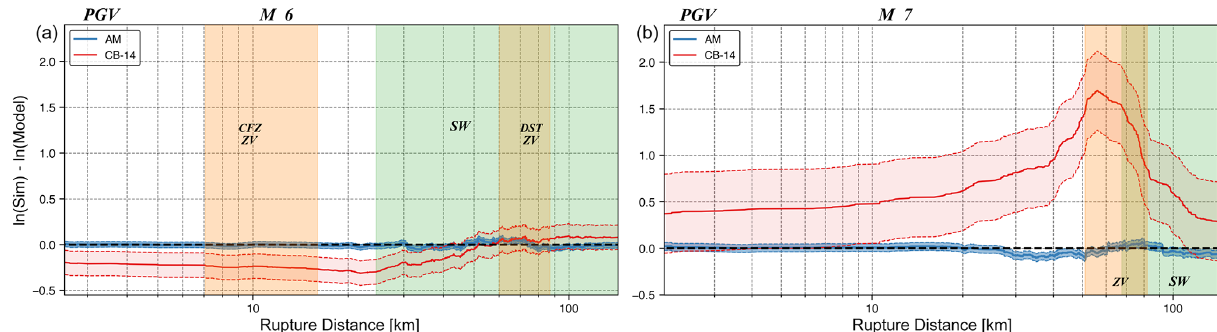
Figure 9. PGV residuals between those simulated (Sim) and predicted by the AM (blue) and CB14 (red) models as a function of rupture distance ( R RUP ) for M 6 (a) and M 7 (b) . Thick lines represent the mean, and the shaded region denotes the standard deviation at each distance. The green and yellow shaded regions indicate the range of rupture distances related to the sedimentary wedge (SW) and the Zevulun Valley (ZV), respectively. Residuals are in ln units.